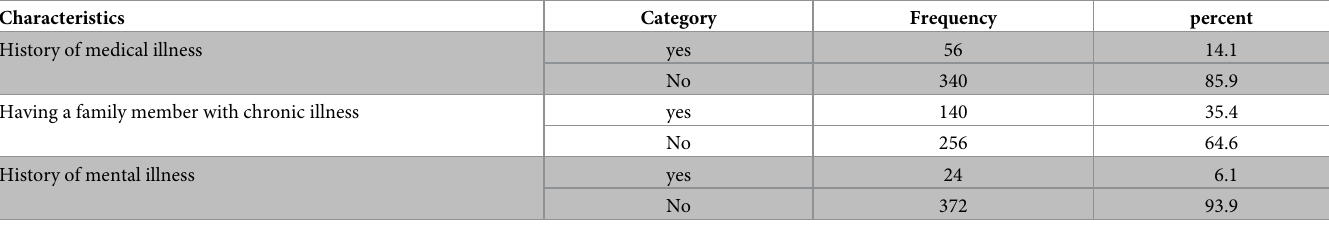
Table 2. Clinical factors of health care providers working in South Gondar zone hospitals, Amhara, Ethiopia, 2020.